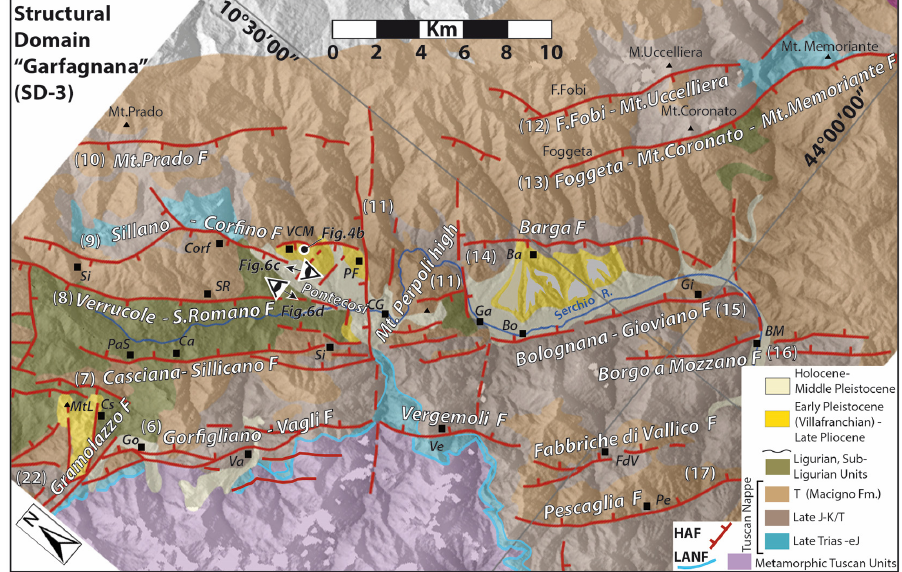
Figure 5. Main fault systems and geology in structural domain SD3 (Garfagnana). The map is derived from [56,57,77,84] and our work. Fault identification numbers are as reported in Table S1. HAF: steep normal faults; LANF: low-angle de-